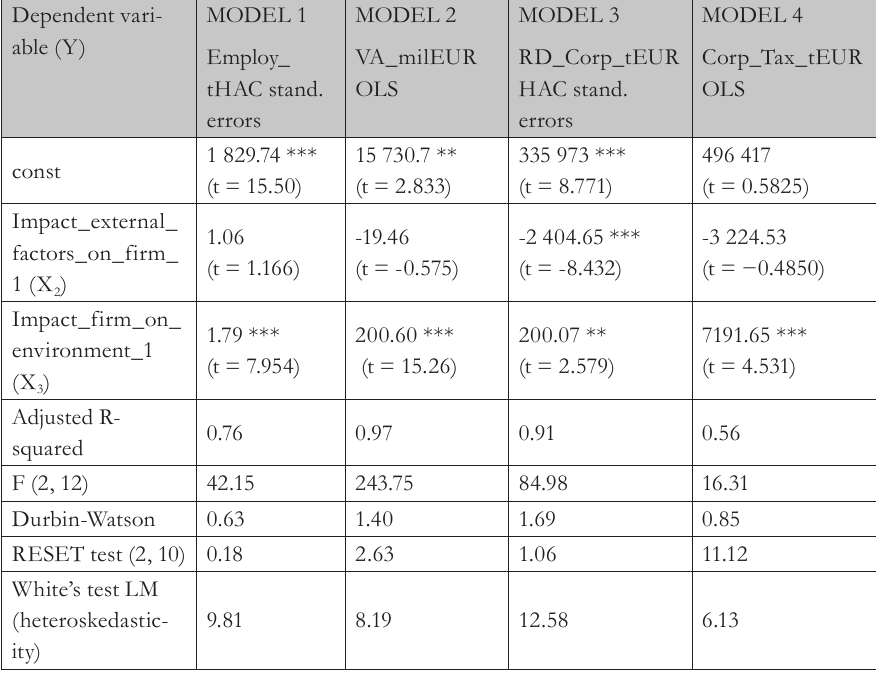
Tab. 5 – OLS model, using observations 2002-2016 (N = 15). Source: own processing by